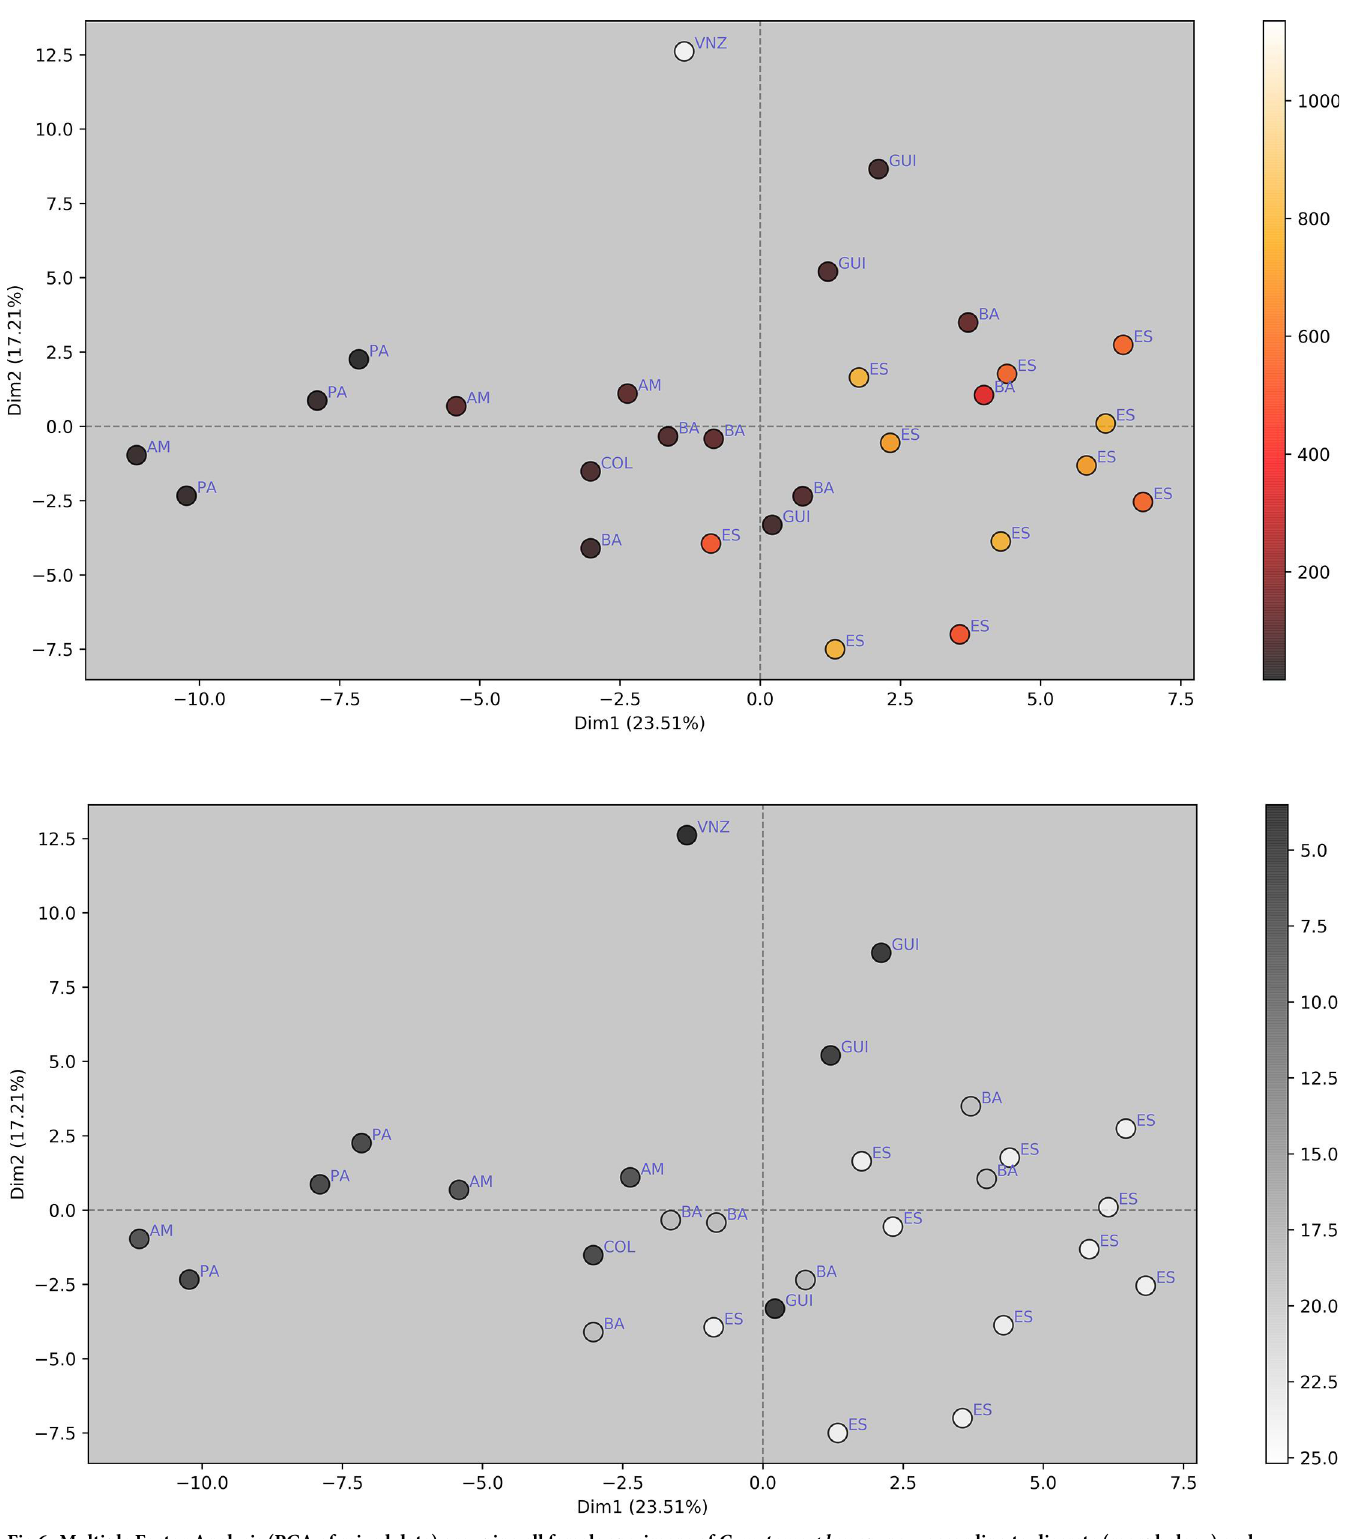
Fig 6. Multiple Factor Analysis (PCA of mixed data) grouping all female specimens of C . metamorphus sp. nov. according to discrete (morphology) and continuous (RGB values) characters (Tables 2 and 4). (A) Color-coded according to altitude. (B) Color-coded according to latitude. Locality abbreviations as in Table 4.